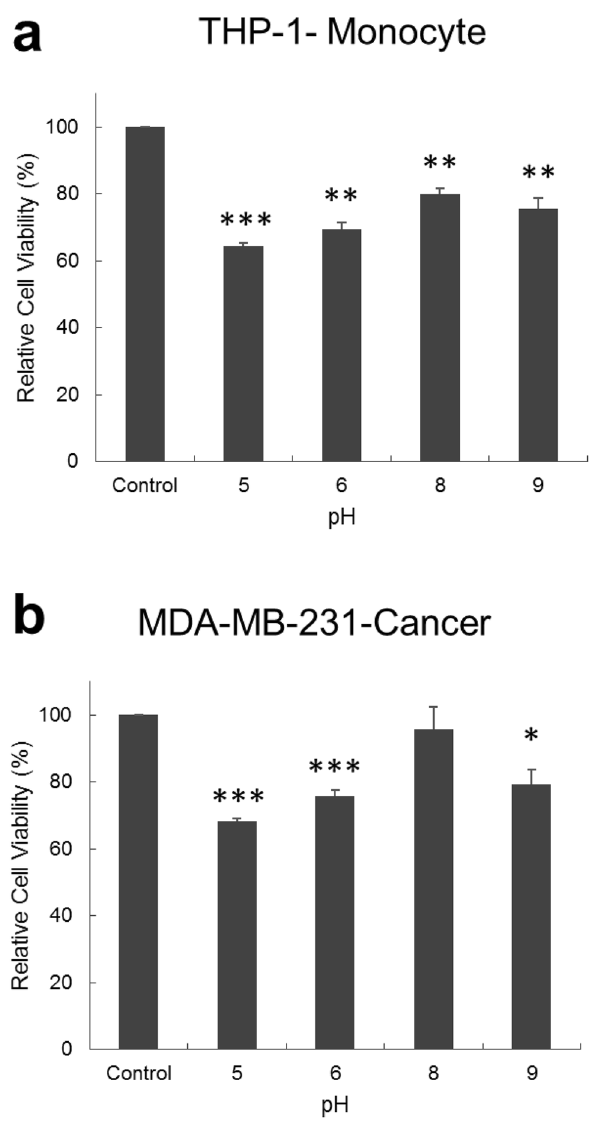
Figure 7. Viability of ( a ) THP-1, human monocyte cell line, and ( b ) MDA-MB-231, human breast cancer cell line, at different pH levels evaluated after 48 h of incubation. Acidic conditions caused a significant decrease in the viability of both cell types. For basic conditions, at pH 8, the viability of THP-1 cells decreased significantly but that of MDA-MB-231 did not. At pH 9, viability of both cell types decreased significantly. Experiment was done in triplicate and the sample number for each replicate is